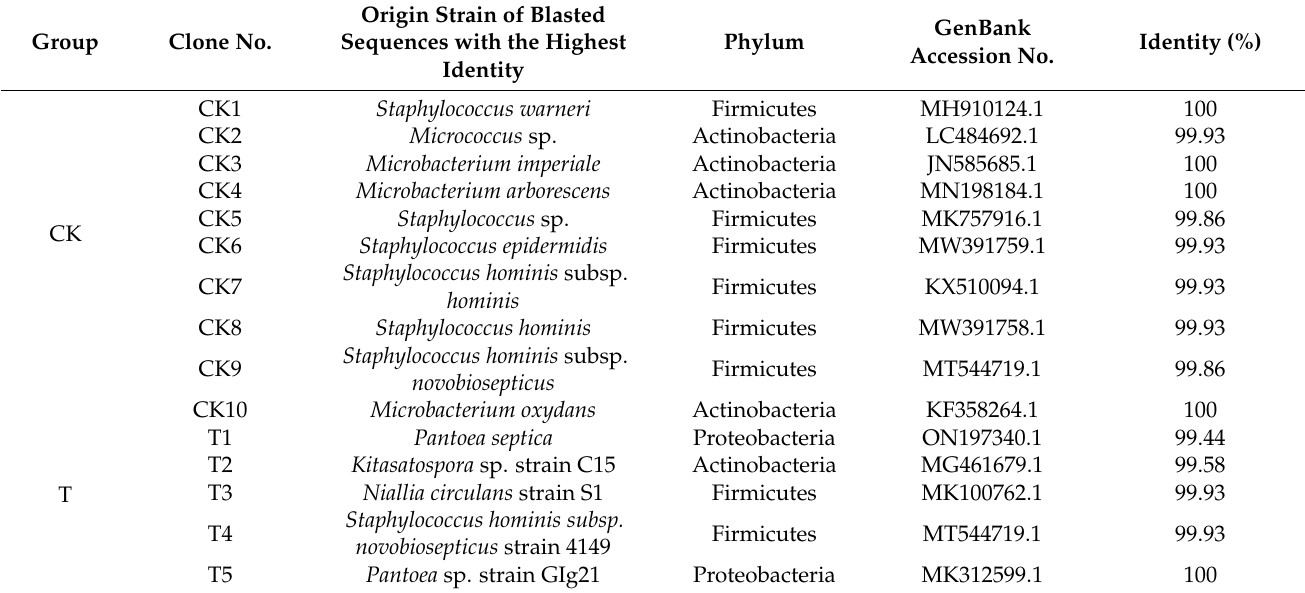
Table 7. NCBI Blast results of 16S sequence of culturable bacteria from Grapholita molesta .